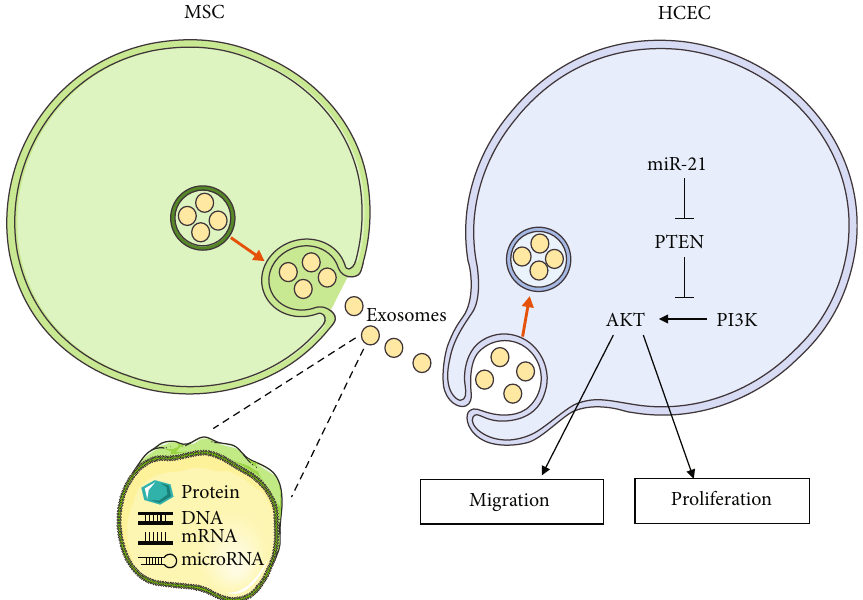
Figure 8: Schematic diagram describes the mechanism of HUMSC-sEVs in corneal epithelial